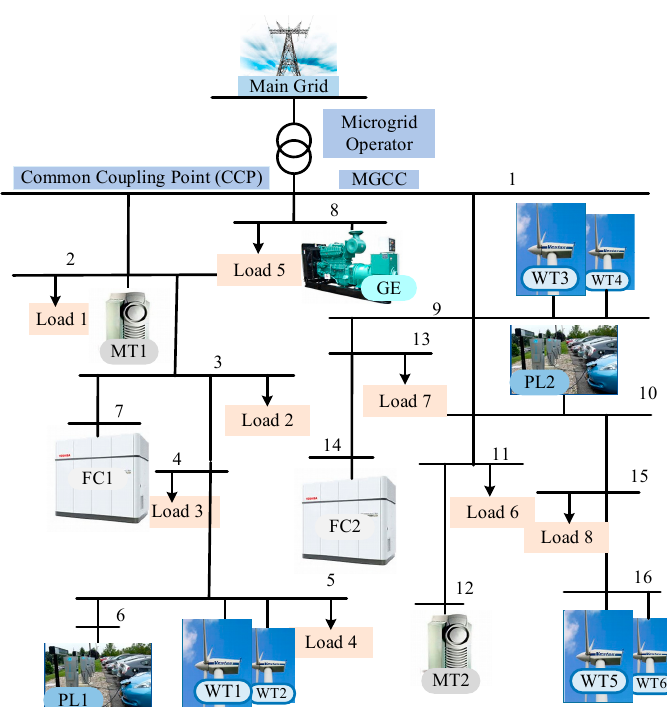
Figure 2. Schematic diagram of the microgrid being studied.